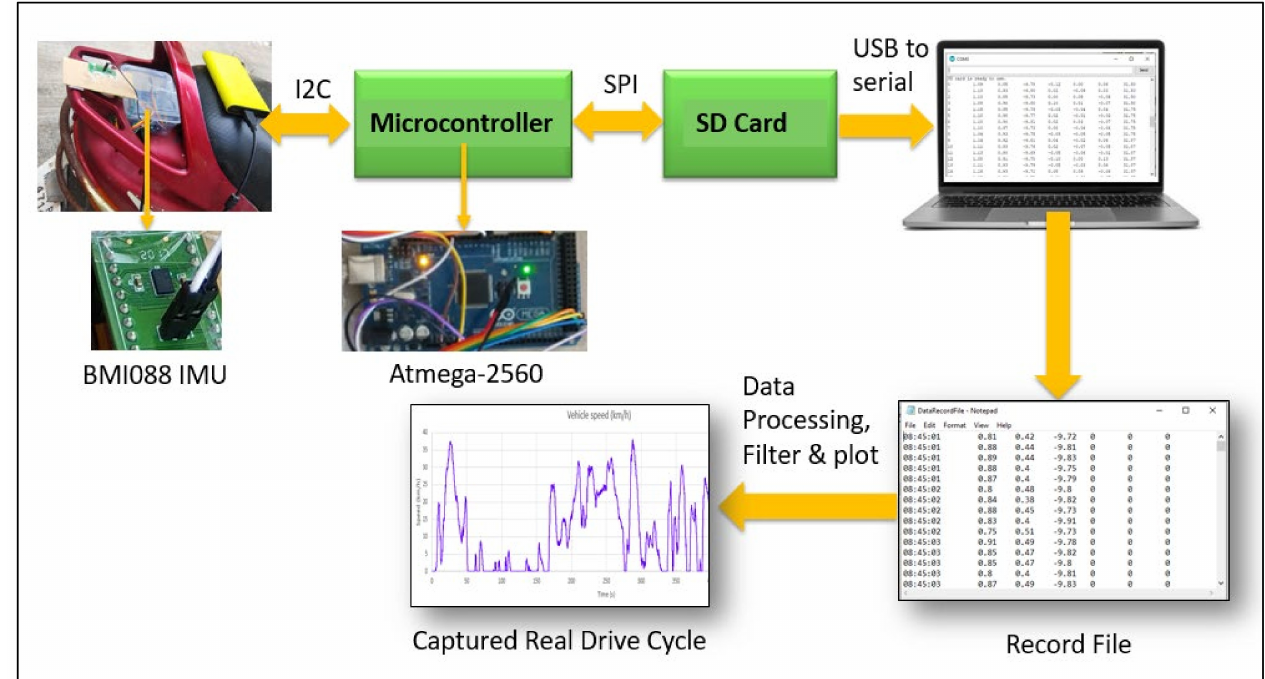
Figure 7. Methodology for data capturing, processing, and